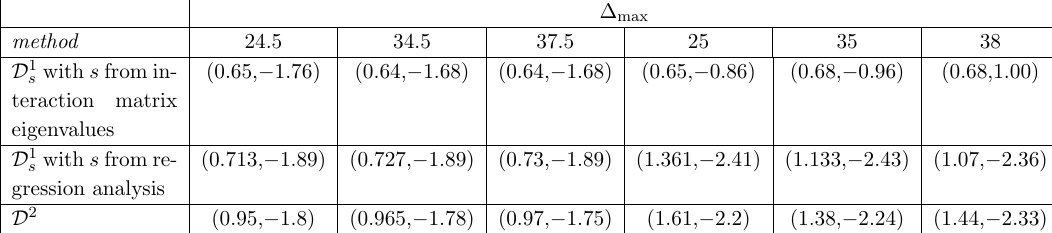
Table 1. Best (cid:12)ts for the leading IR exponent t , for the free spectator.